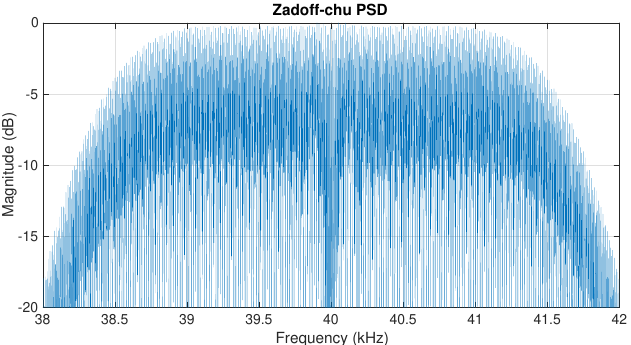
Figure 4. Power spectral density of transmitted Zadoff–Chu sequence ( x [ n ] ).